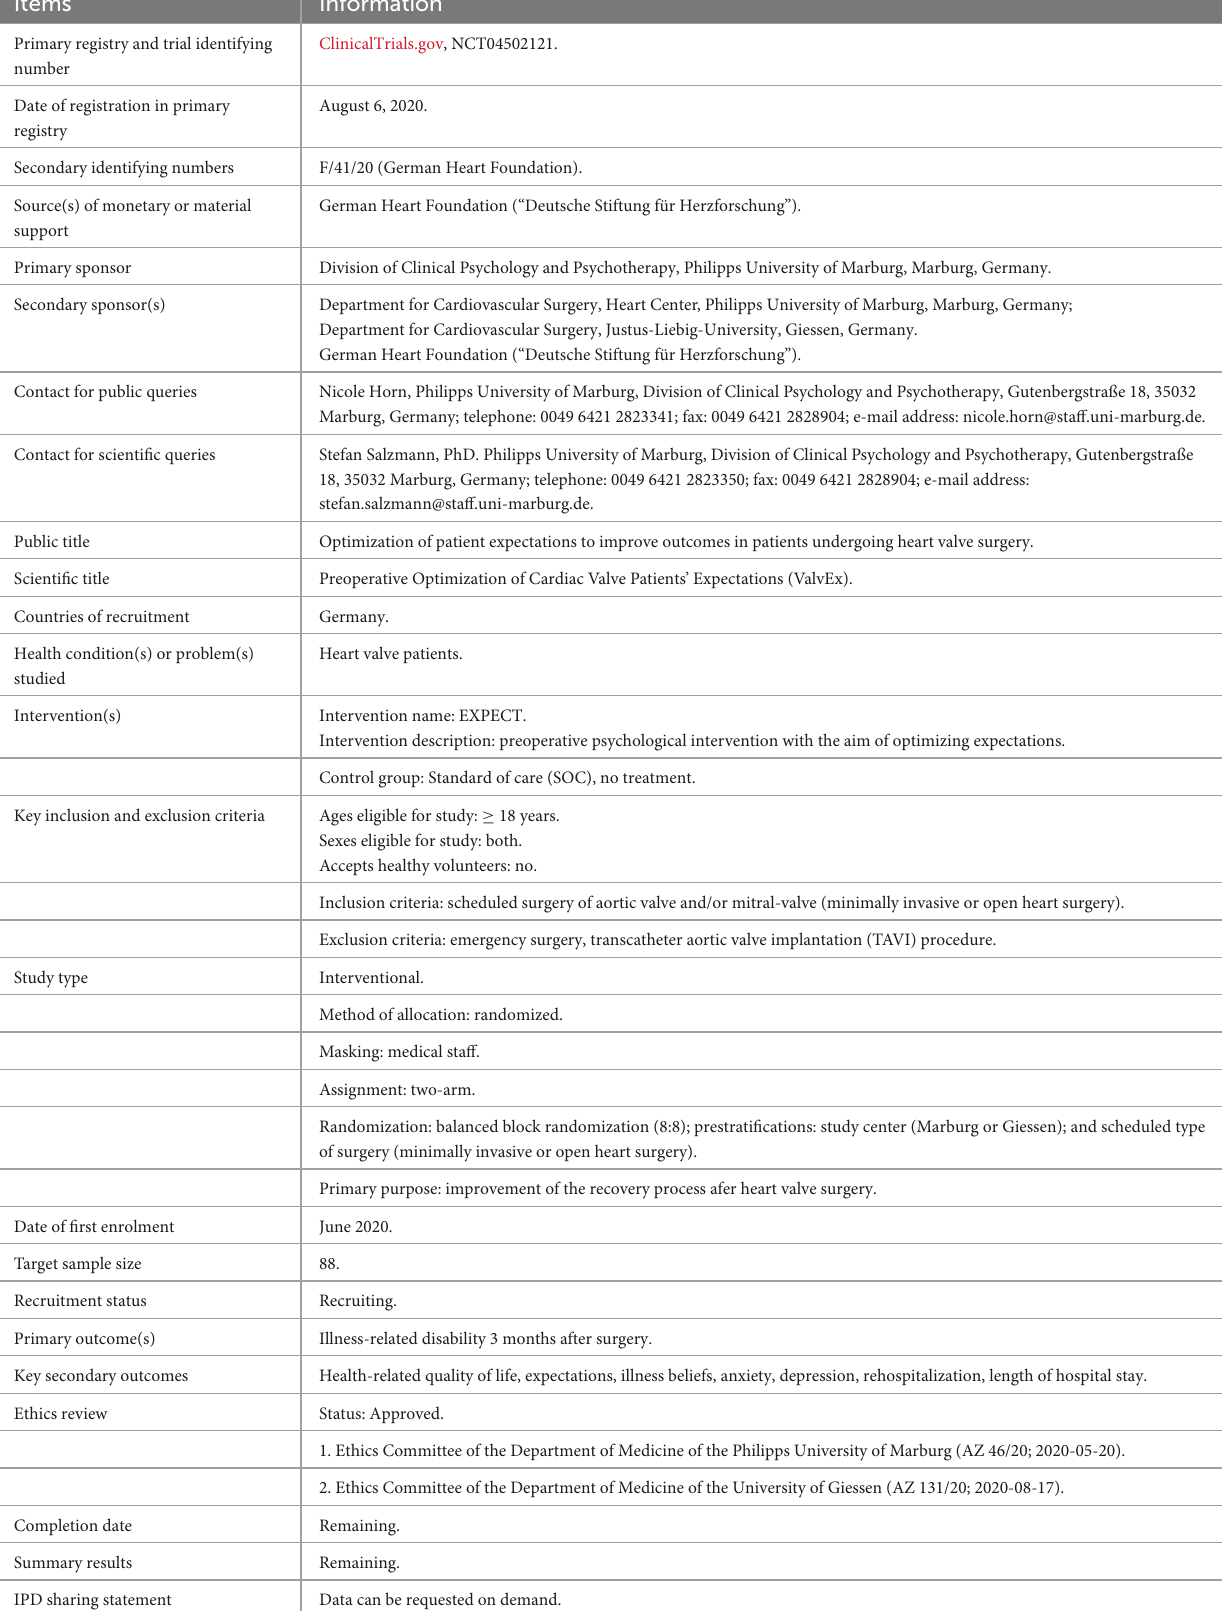
TABLE 1 World Health Organization trial registration data